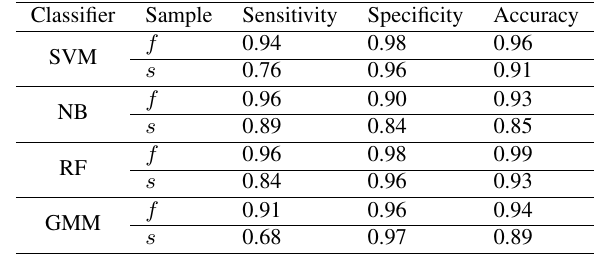
Table 4. Comparison of performances with different training data on the crown subset. Sample f denotes the manually selected 10% training set. Sample s refers to a training set with 1m